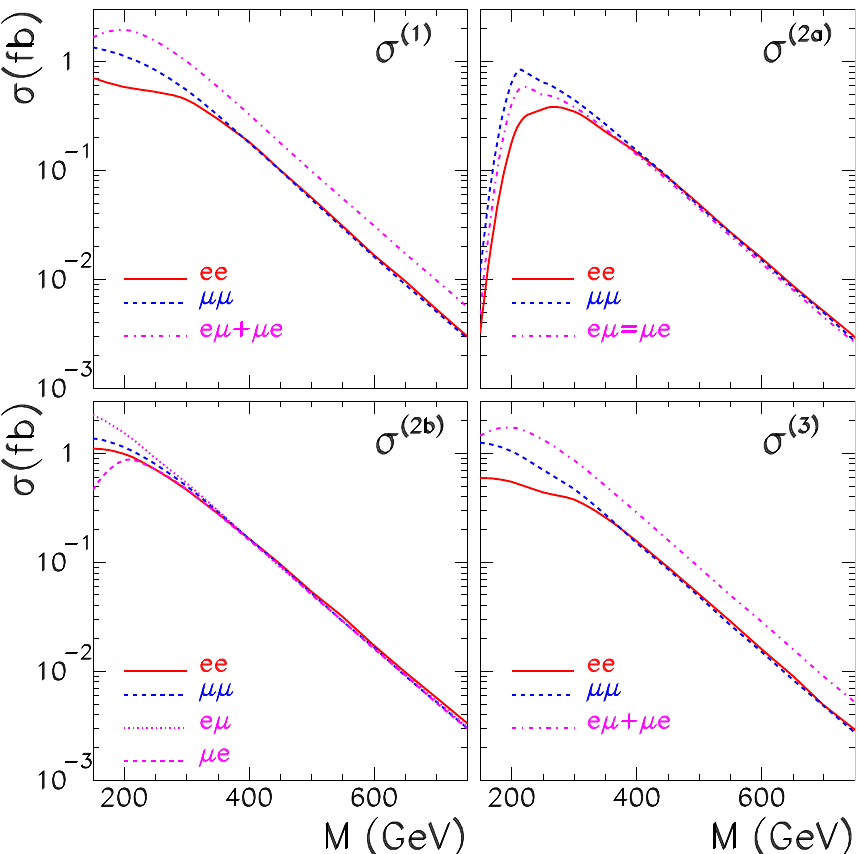
Figure 2 . Cross section factors for the di(cid:11)erent contributions to the event topologies as a function of the triplet mass M as de(cid:12)ned in eqs. (3.1){(3.5) after inclusion of our simulation of the selections of ref. [22] (see text for